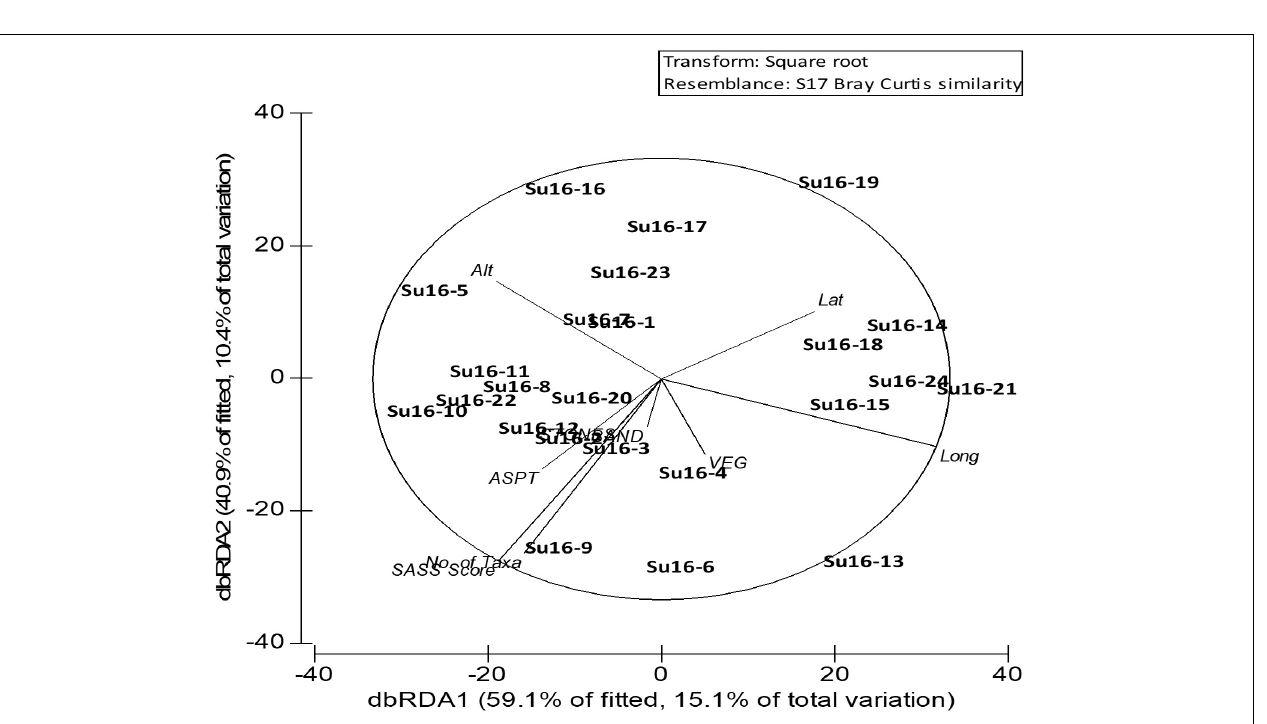
FIGURE 3 | Redundancy Analysis (RDA) of SASS indices, biotope availability and geographic location, using macroinvertebrate abundance in KwaZulu-Natal rivers in summer 2016. Alt, altitude; Lat, latitude; Long, longitude; VEG, vegetation; ASPT, average score per taxon; SASS Score, South African Scoring System score; Su16, summer